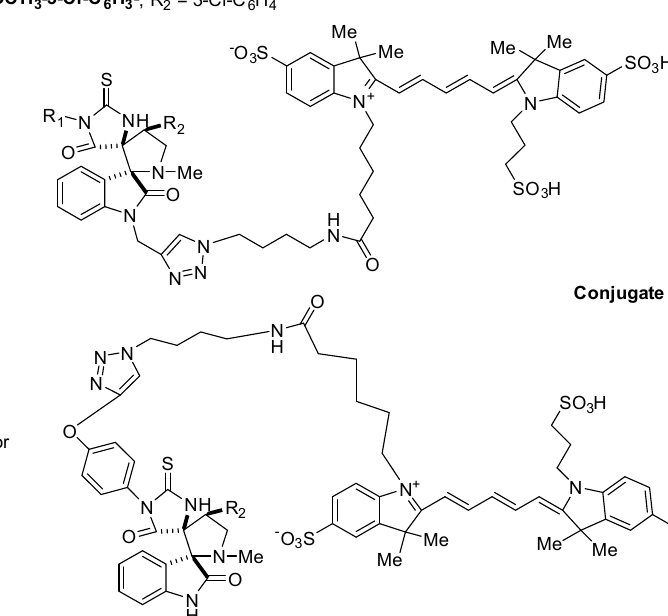
Scheme 2. Click reaction between the fluorescent dye Sulfo-Cy5-azide and dispiro -indolinones 69 and 35 .